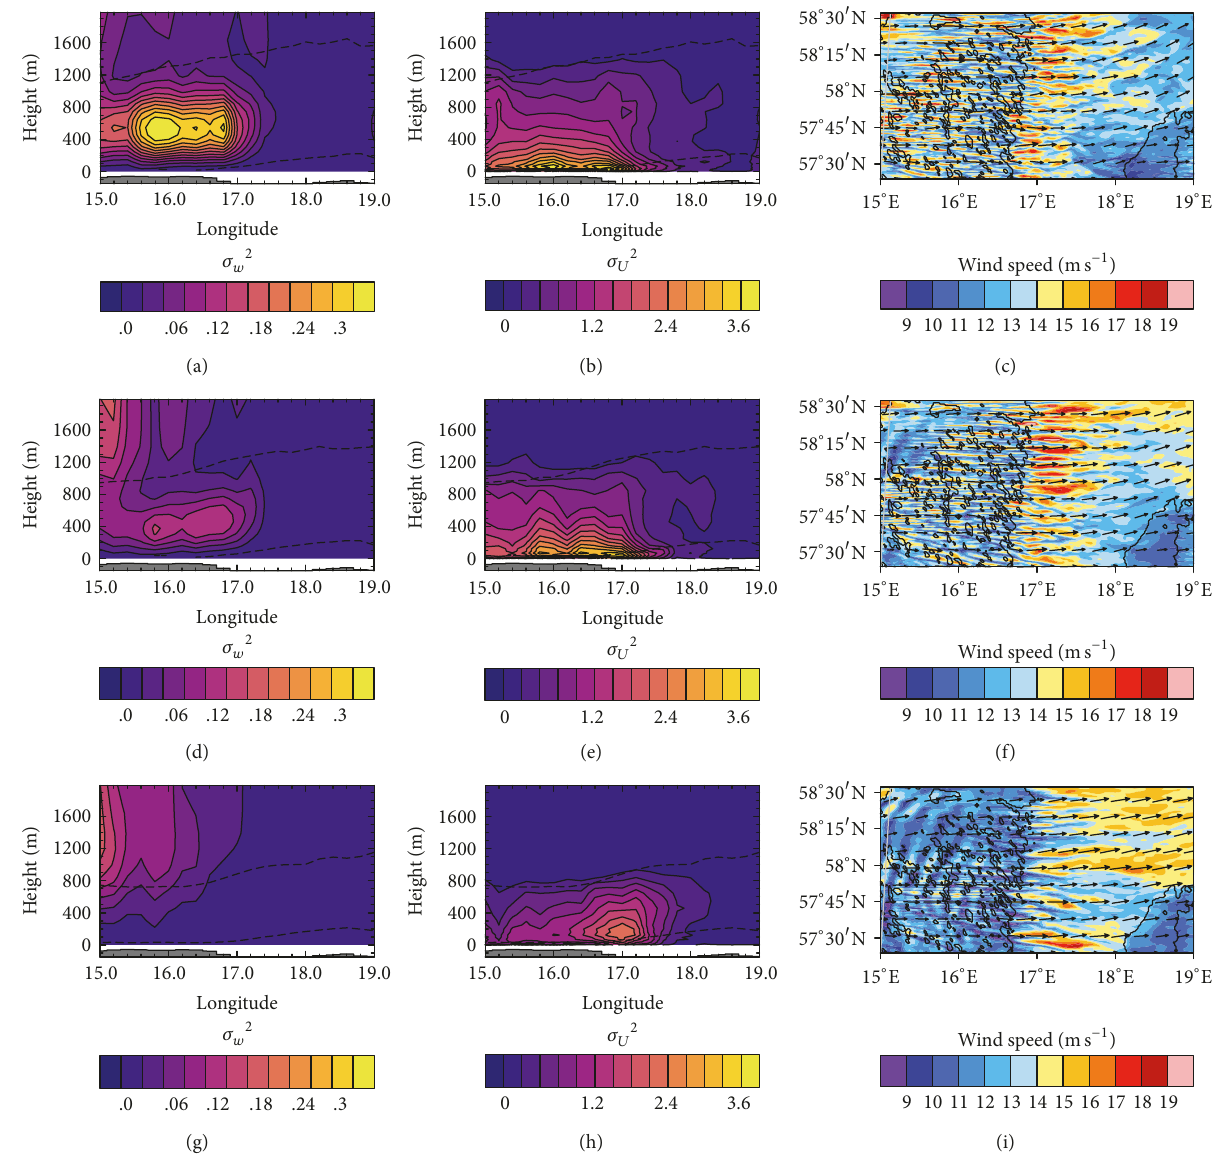
Figure 9: (a, b, d, e, g, h) show the cross-wind variance of (a, d, g) vertical wind speed and (b, e, h) horizontal wind speed. (c, f, i) show the horizontal wind field at approximately 100 m height in the area over which the variance is calculated. The figures are from times (a, b, c) 1400 UTC, (d, e, f) 1600 UTC and (g, h, i) 1800 UTC. The dashed lines in (a, b, d, e, g, h) show the approximate inversion height below and above 400m height. The grey area below the plots shows the average ratio of land at each latitude.